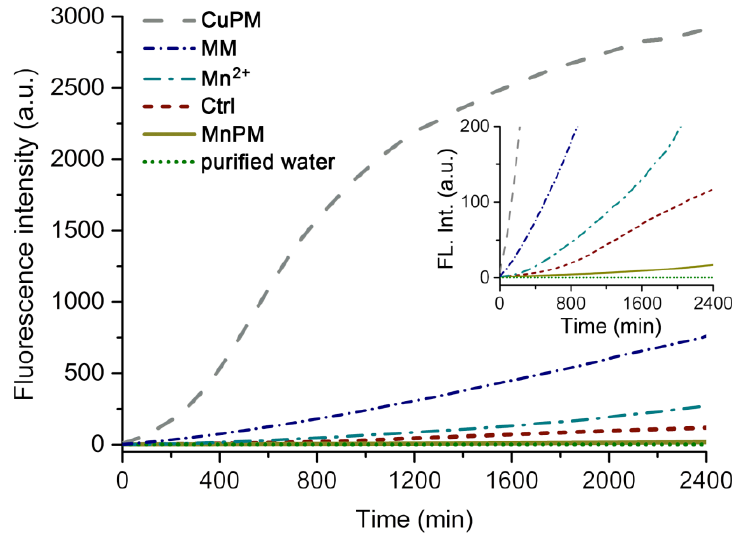
Figure 4. Fluorescence intensity of DCF ( λ ex = 485 nm, λ em = 650 nm) by (H 2 en) 6 [Cu(en)(H 2 O)][Cu(en)(H 2 O) 3 ][P 2 Mo 5 O 23 ] (CuPM), manganese molybdate (MM), MnCl 2 (Mn 2+ ), blank group (Ctrl), (H 2 en) 3 [Mn(H 2 O) 4 ][Mn(H 2 O) 3 ] 2 [P 2 Mo 5 O 23 ] 2 (MnPM), and purified water (inset, the expanded graph of the fluorescence intensity in the range of 0 to 200) from 0 to 2400 min.